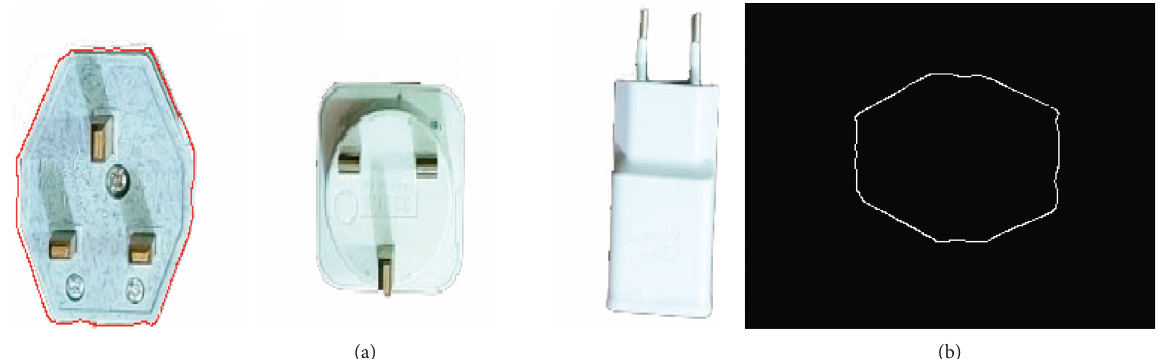
Figure 7: The matching of sample 1: (a) product image captured; (b) template